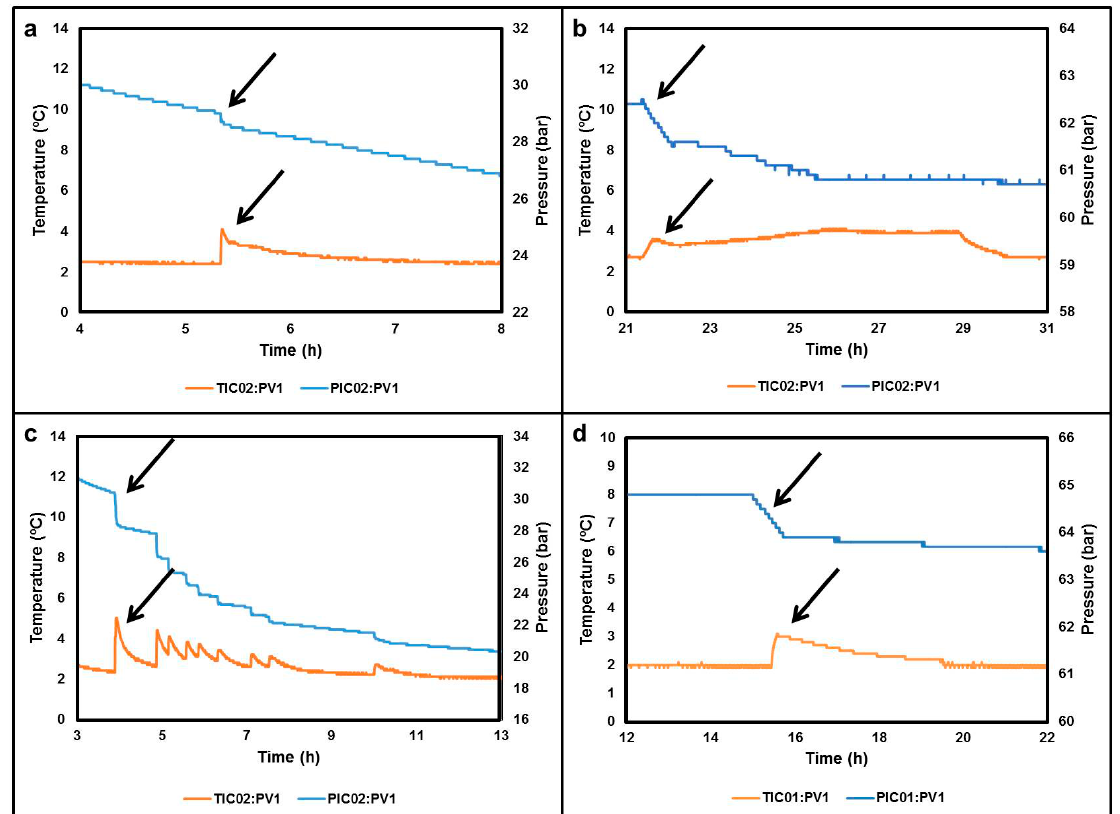
Figure 10. Gas hydrate (GH) synthesis with CO 2 in pure water ( a ), CH 4 in pure water ( b ), CO 2 in saline water ( c ), and CH 4 in saline water ( d ).